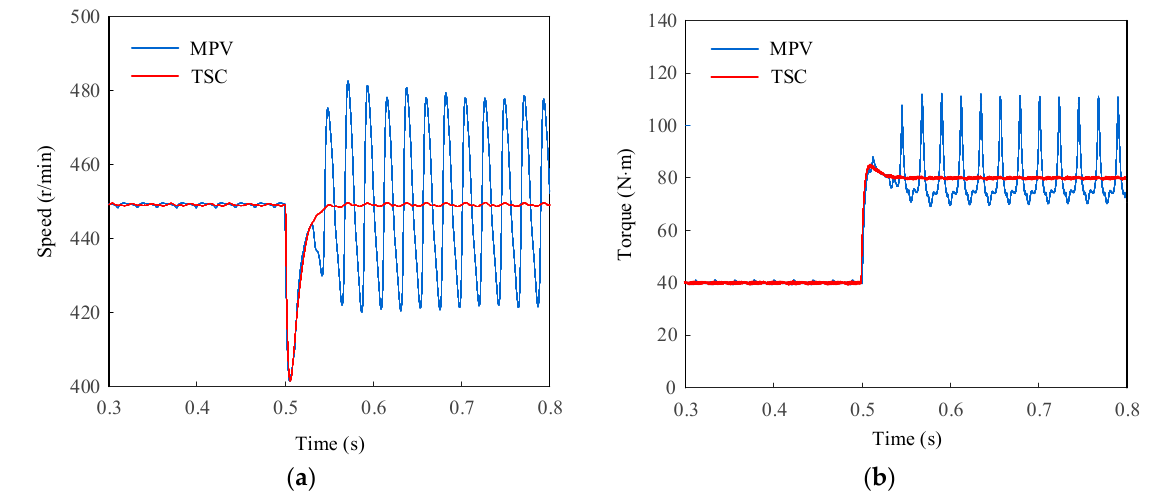
Figure 11. Improved load torque simulation results for the MPV and TSC control for faulty dual three-phase PMSM. ( a ) Speed. ( b ) Torque.